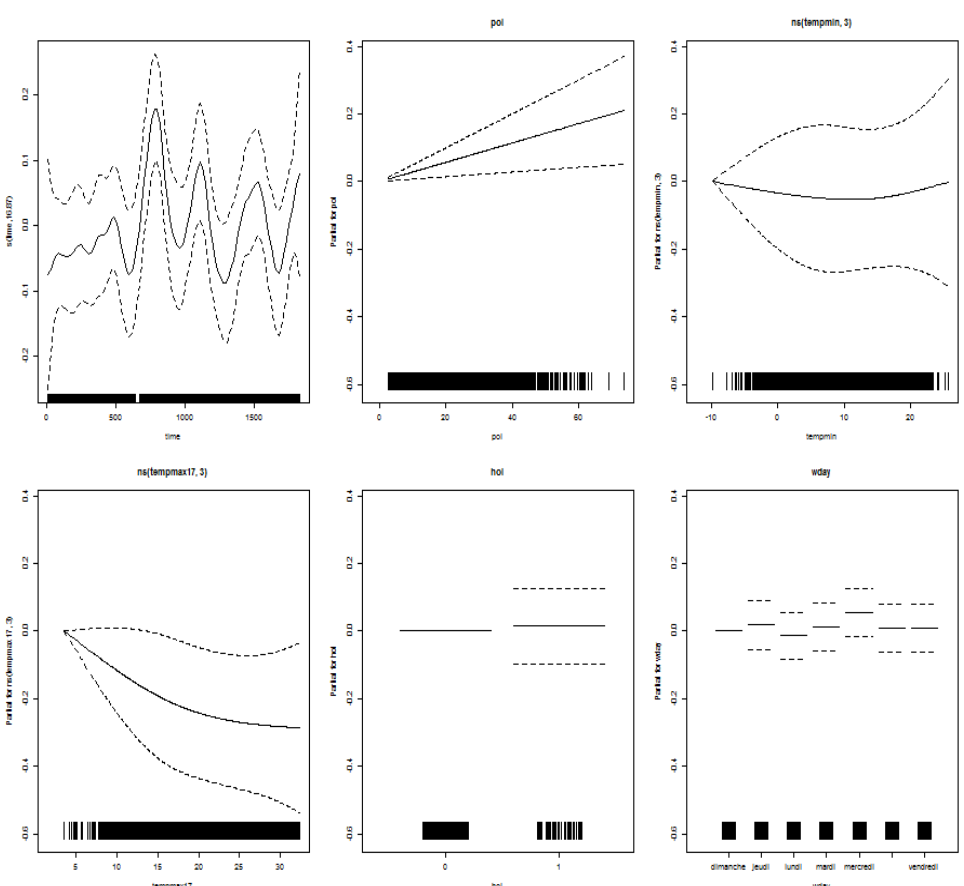
Figure A2. Assessment of the modeling assumptions for Montpellier.